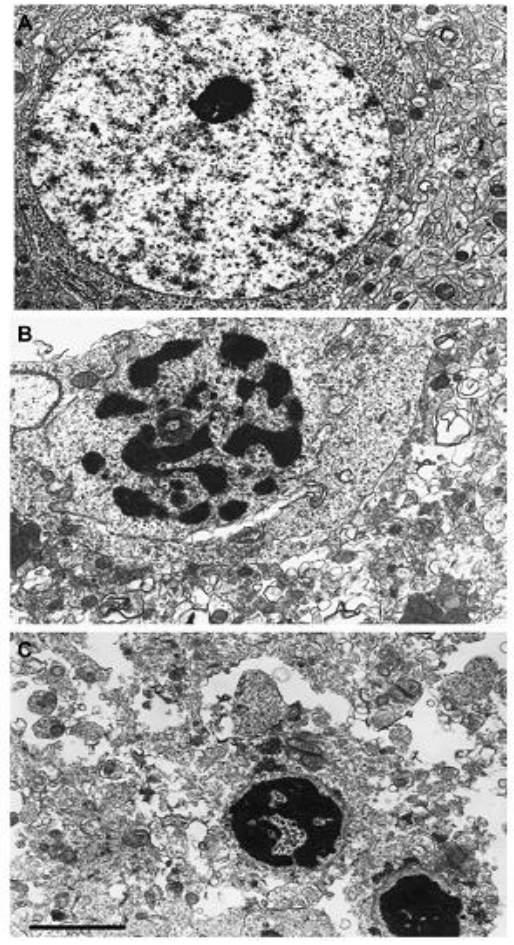
FIGURE 2. Electron micrographs (EM) show a normal neuron with intact cytoplasm and nuclear membrane from a PND 7 control rat (A). EMs also show typical nuclear fragmentation (B) and nuclear condensation (C) that represent advanced states of apoptosis in layer II and III of the frontal cortex from ketamine-treated (20 mg/kg × six injections) rat brain. Scale bar = 0.64 µm. From Zou et